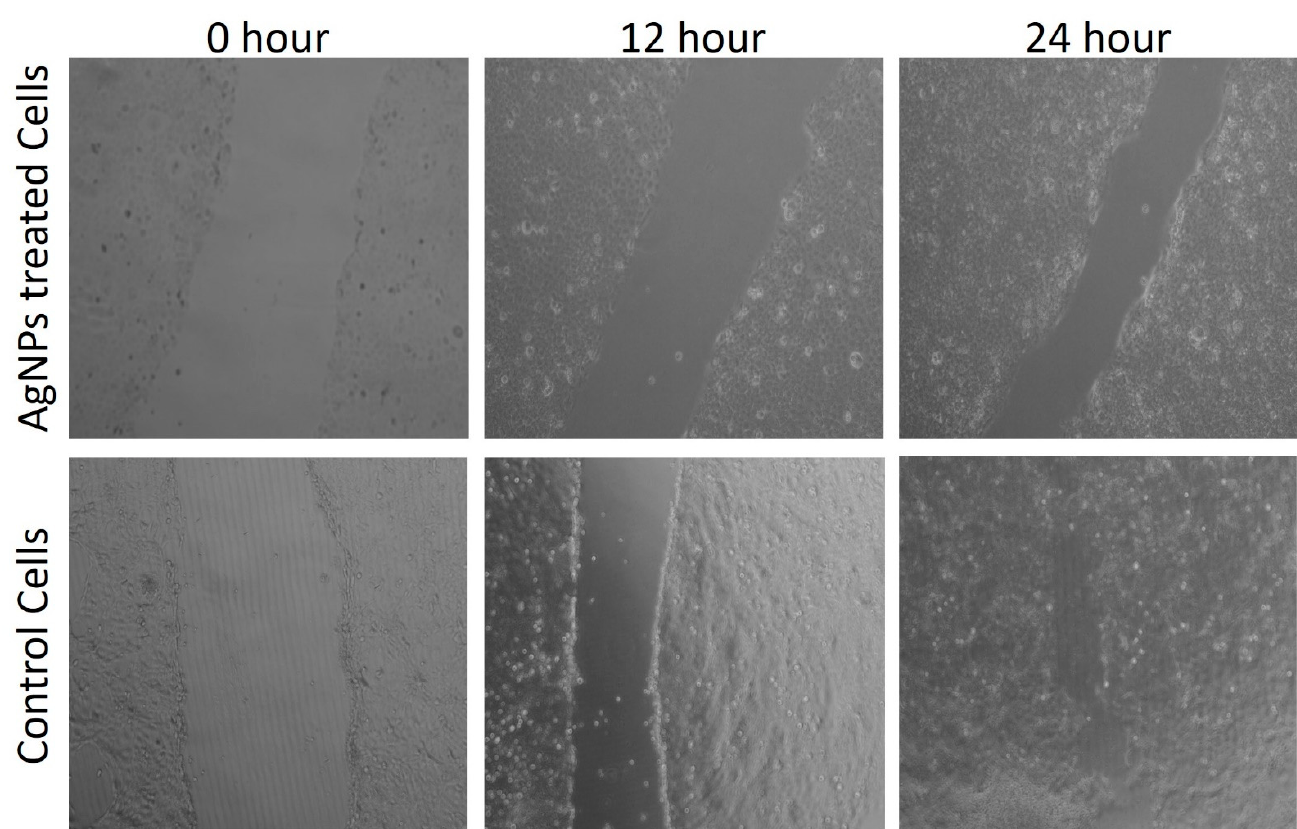
Figure 11. Scratch wound healing assay of the green-synthesized T. funiculosus –AgNPs against MDA-MB-231 breast cancer cells and control cells.